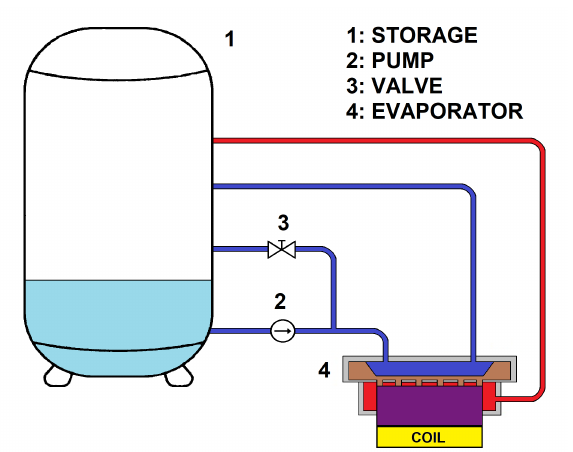
Figure 3. Typical structure of the pumped two-phase (P2P)